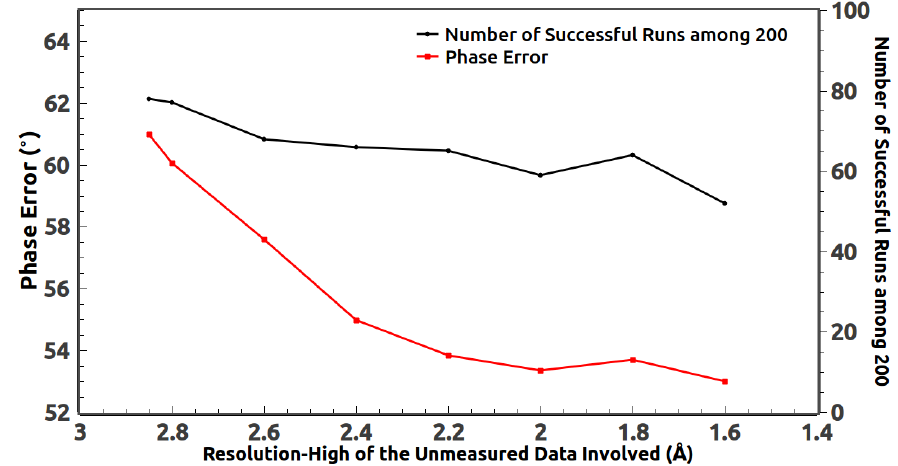
Figure 10. The diffraction data of 2JLN are measured up to 2.85 Å. When some unmeasured high-resolution reflections are involved into the HIO phasing, a lower phase error can be achieved with a slightly decreased success